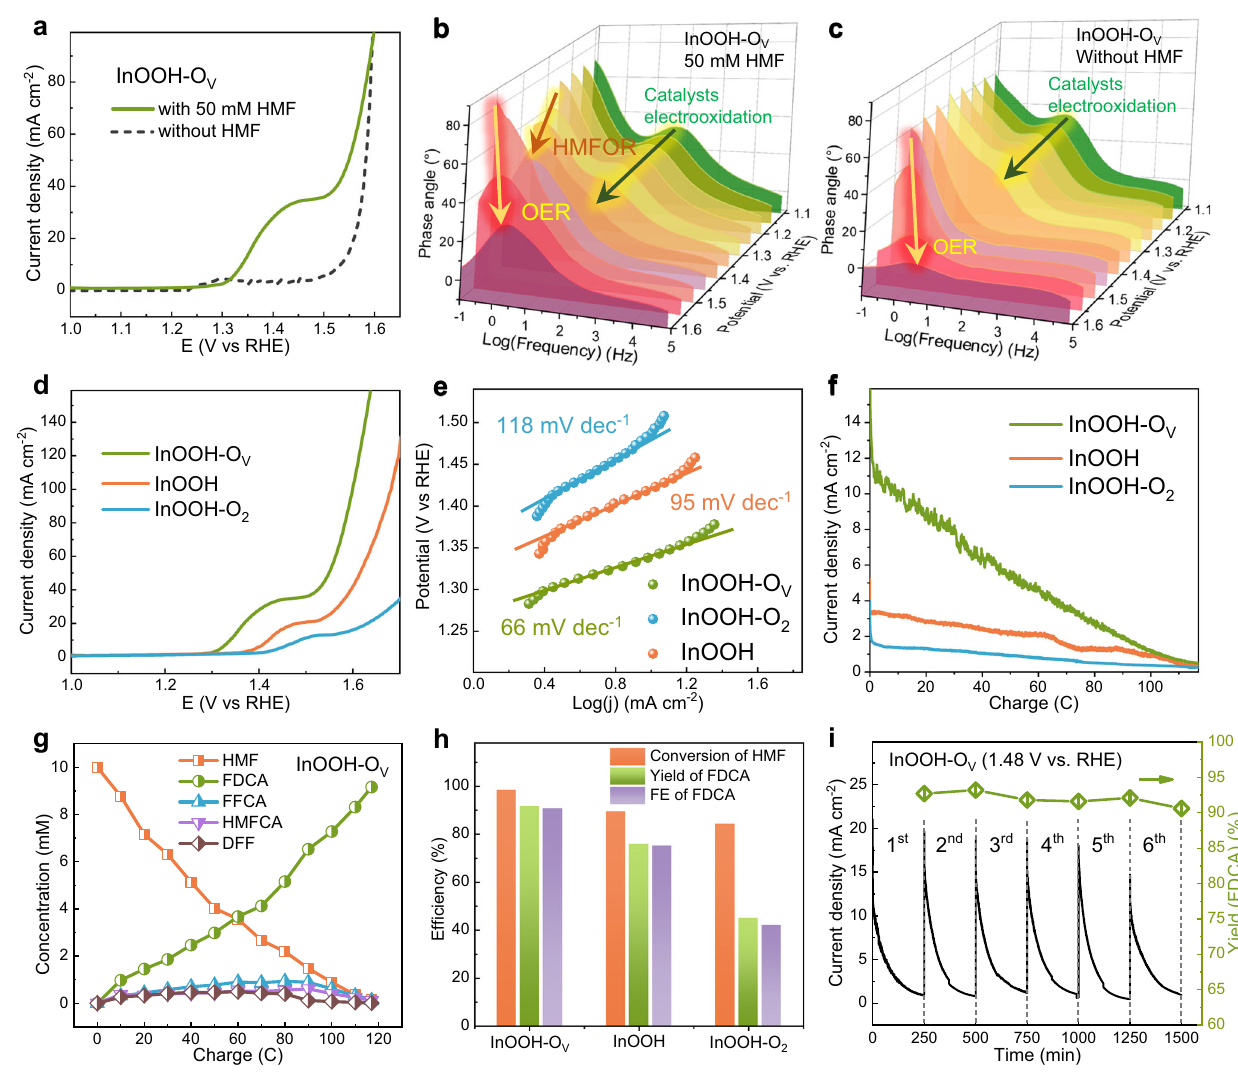
Fig.4|ElectrochemicalperformancesforHMFOR.a TheLSVcurvesofInOOH-O V in the electrolyte with and without HMF. b , c Bode phase plots of InOOH-O V in the electrolytes with and without HMF. d The LSV curves of InOOH-O V , InOOH, and InOOH-O 2 in 1M KOH solution with 10mM HMF at 5mVs − 1 . e The corresponding